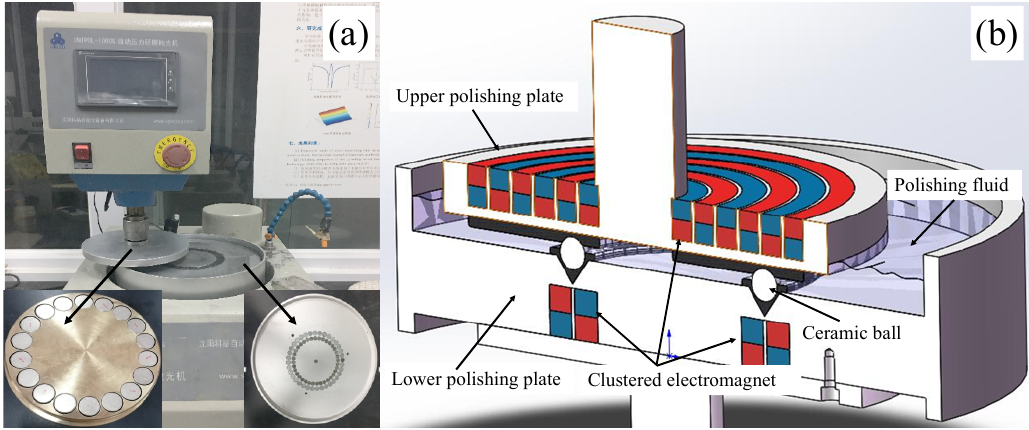
Figure 2. Experimental setup: ( a ) the machine tool of the clustered magnetorheological finish ( b ) cross-section of the CMRF machine.